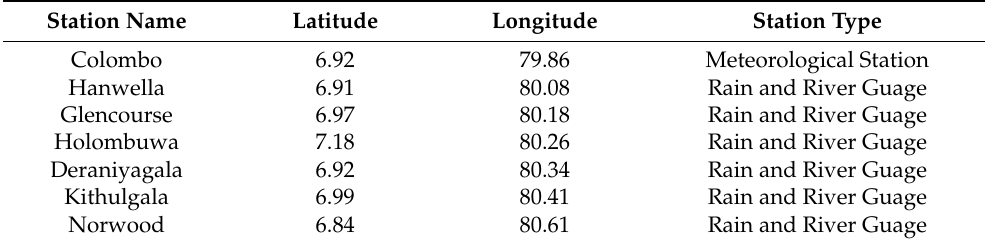
Table 1. Characteristics of the rainfall stations. Observed and satellite-based data were collected for the seven rainfall stations, and locations were selected on the basis of the upper, middle, and lower parts of the